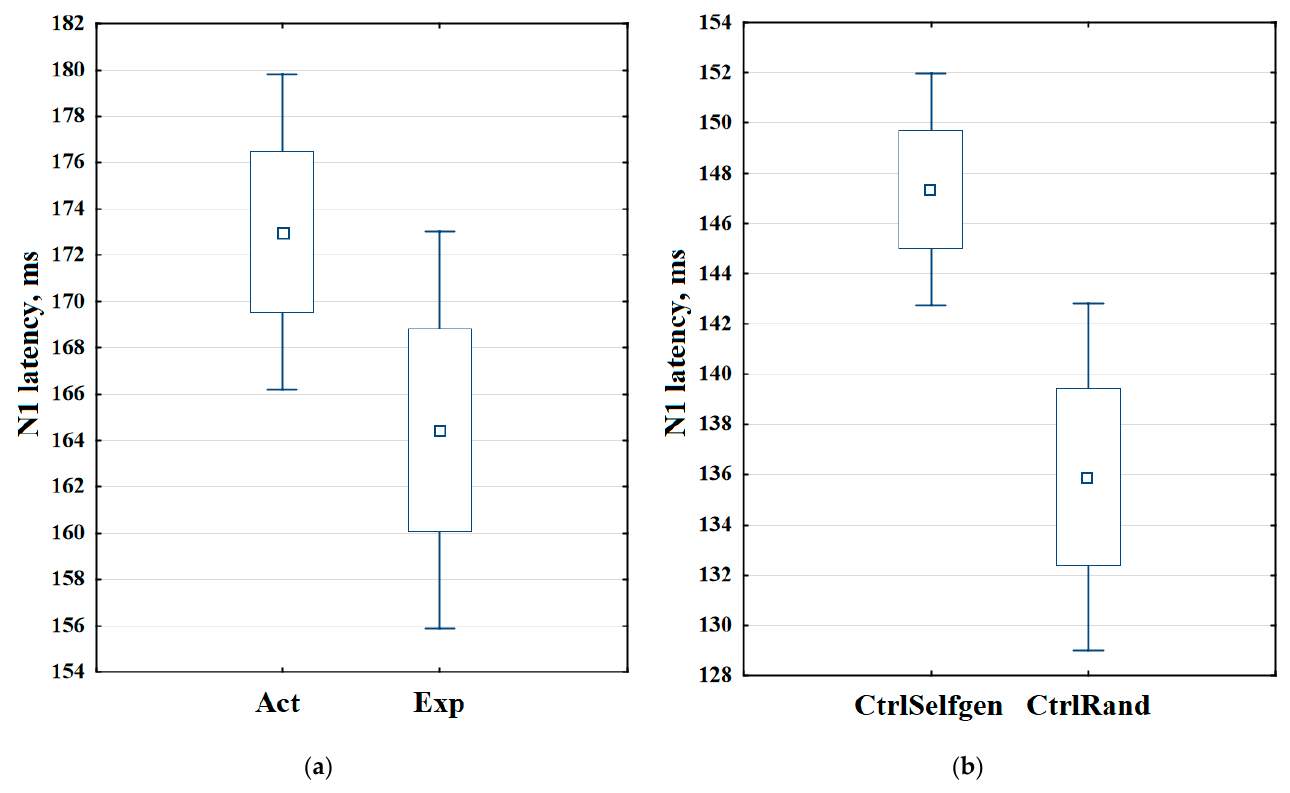
Figure 7. Box plots of latency in the N1 component in the auditory ERP in different conditions. ( a ) In the Act and Exp conditions; ( b ) in the CtrlSelfgen and CtrlRand conditions.